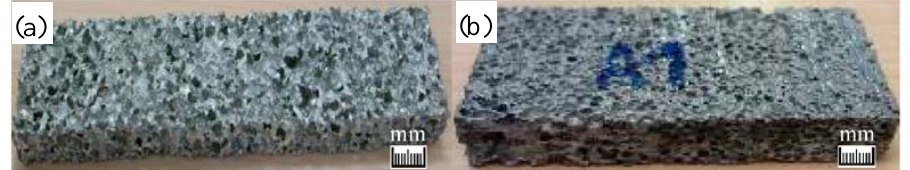
Figure 11. ( a ) Alpora’s foam (0.25 to 0.4 Kg/dm 3 ); and ( b ) Formgrip’s foam (0.4 to 0.65 Kg/dm 3 ).